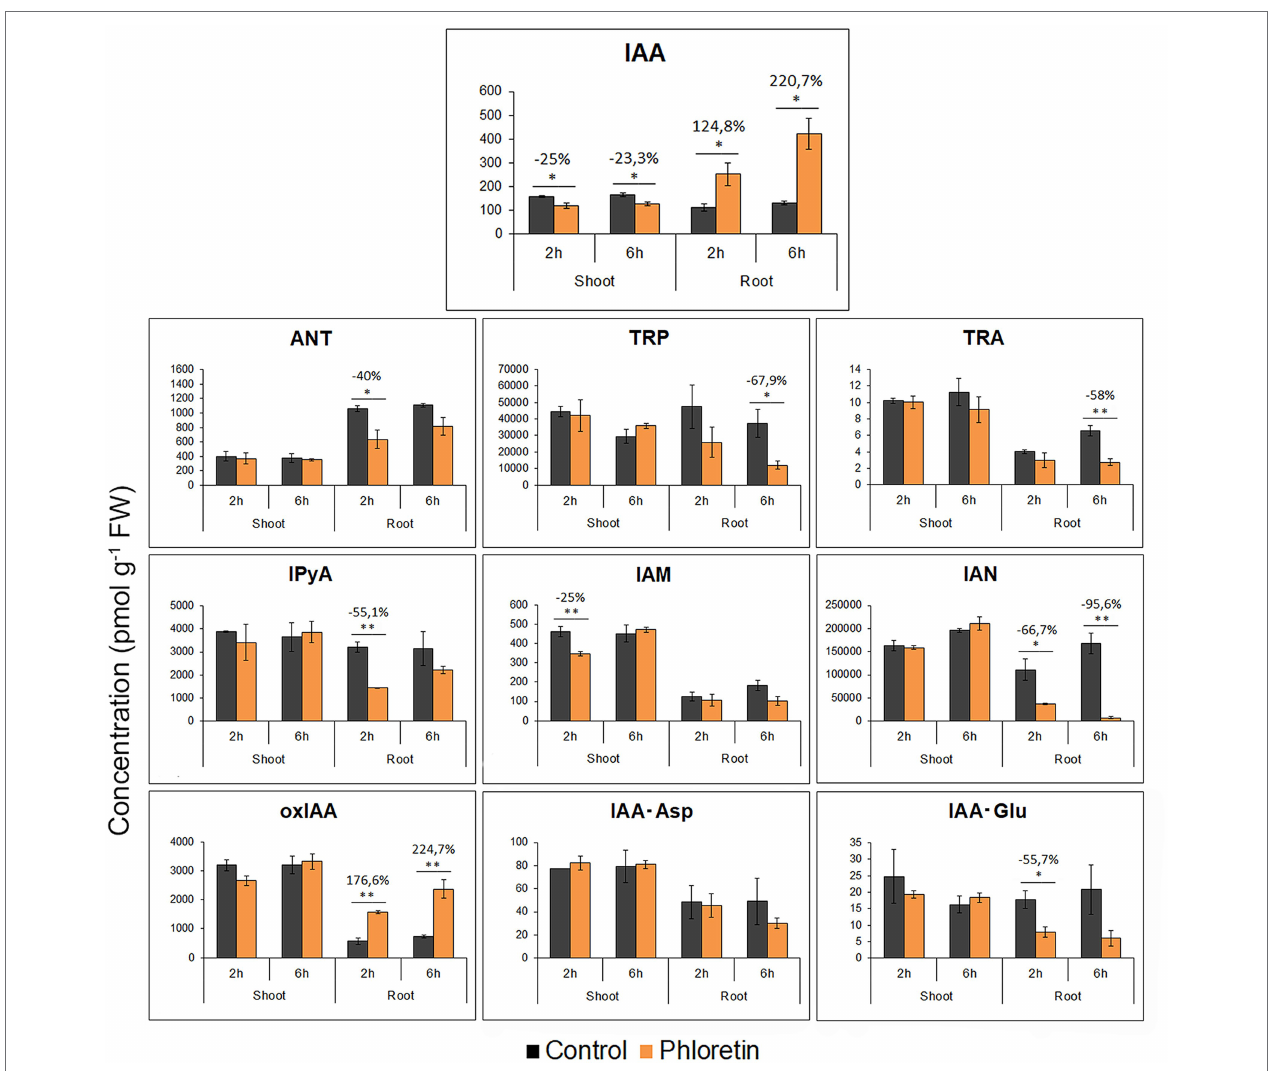
FIGURE 6 | Phloretin disturbs the auxin metabolome profile in Arabidopsis. Quantification of IAA (Indole-3-acetic acid), IAA precursors: anthranilate (ANT), tryptophan (TRP), tryptamine (TRA), indole-3-pyruvic acid (IPyA), indole-3-acetamide (IAM), indole-3-acetonitrile (IAN); IAA degradation intermediate: 2-oxindole-3- acetic acid (oxIAA); IAA conjugates: indole-3-acetylaspartic acid (IAA-Asp) and indole-3-acetylglutamic acid (IAA-Glu) in 5 days after germination (DAG)-old control seedlings or seedlings treated with 500 μ M phloretin for 2 or 6 h. Values are presented as means ± SE of three biological replicates (samples from three independent experiments). Asterisks indicate statistically significant difference at * p < 0.05 and ** p < 0.01 based on Student’s t -test, while numbers above the bars indicate the percentage of auxin metabolite content increase (+) or decrease ( − ) compared to